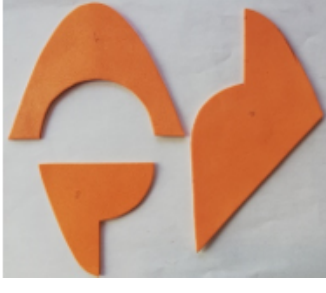
Figure 2. Bi-dimensional objects to